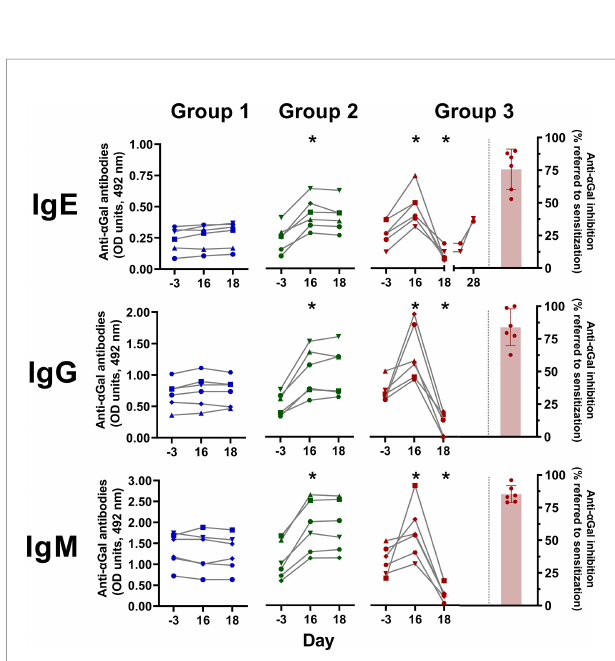
FIGURE 6 | A. sculptum salivary gland extract signi fi cantly induced anti- a Gal antibodies in GalT-KO mice. Animals from Group 1 (in blue, n=6) are a double negative control (PBS for sensitization and treatment, respectively). Animals of Group 2 (in green, n=6) and 3 (in dark-red n=6) were sensitized to a Gal according to Figure 2 . In Group 3, after sensitization, animals were treated with three consecutive DP1000-RA0118 doses (10 mg/kg, sc.) on days 16, 17, and 18. The challenge was repeated in two animals of Group 3 on day 26, one week after the last treatment with DP1000-RA0118. Red columns represent the anti- a Gal inhibition on day 18 (% referred to sensitization on day 16) in Group 3 (treated with DP1000-RA0118). Wilcoxon matched-pairs signed-rank was used as a non-parametric test (*: p <